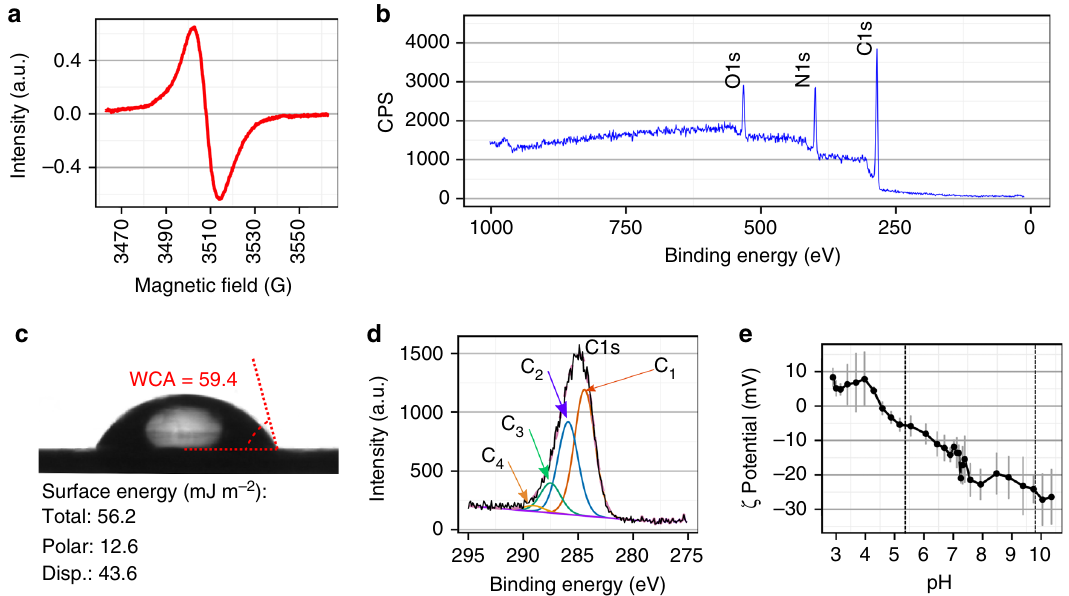
Fig. 2 The surface has radicals and a range of charge states. a Electron paramagnetic resonance spectrum of the radical-functionalized plasma polymer (RFPP) showing a broad and symmetrical peak, indicative of unpaired electrons associated with radicals. b X-ray photoelectron spectroscopy (XPS) survey spectrum of the RFPP fi lm showing a surface elemental composition of carbon (71.3 at.%), nitrogen (19.6 at.%) and oxygen (9.1 at.%). No sulfur or titanium is detected on the surface. c Water contact angle (WCA) of the RFPP surface. The total, polar and dispersive (Disp.) surface energies are given. d XPS C 1 s high-resolution spectra of the RFPP fi tted with four components, C 1 : C − C/C − H, C 2 : C − O/C − N, C 3 : C = O/N − C = O and C 4 : COOH. e The changes of zeta potential as a function of pH show that the surface is negatively charged above pH 4.5, with the negative charge saturating at pH ≅ 7.5. The dashed lines indicate the pH values used in the immobilizing solutions. Error bars are s.d. ( e